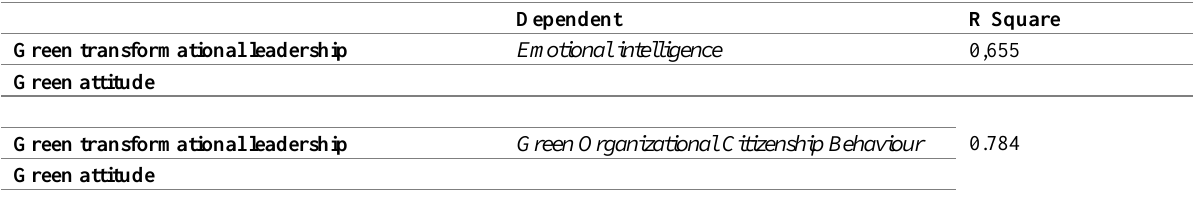
Table 5: R-Square test